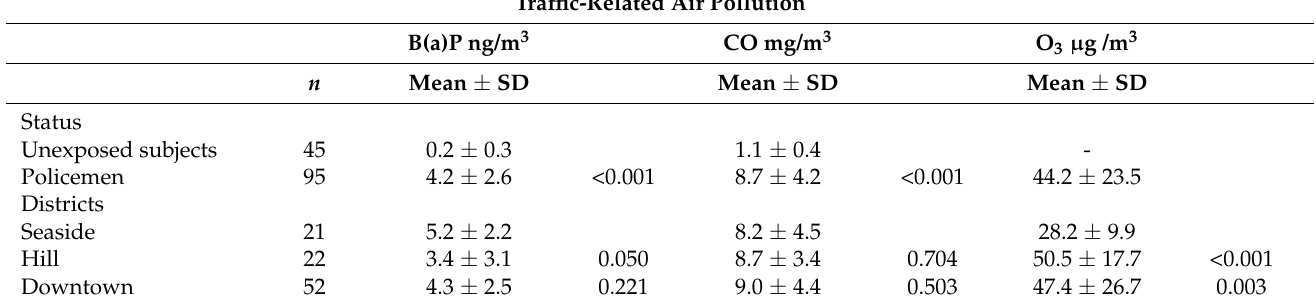
Table 1. Concentrations of benzo(a)pyrene [B(a)P] ng/m 3 , carbon monoxide (CO mg/m 3 ), and ground-level ozone (O 3 ) µ g/m 3 by personal exposure monitoring or local monitoring stations in the city air of Genoa, Italy. Air pollutants are also reported according to working districts (seaside, hill, and